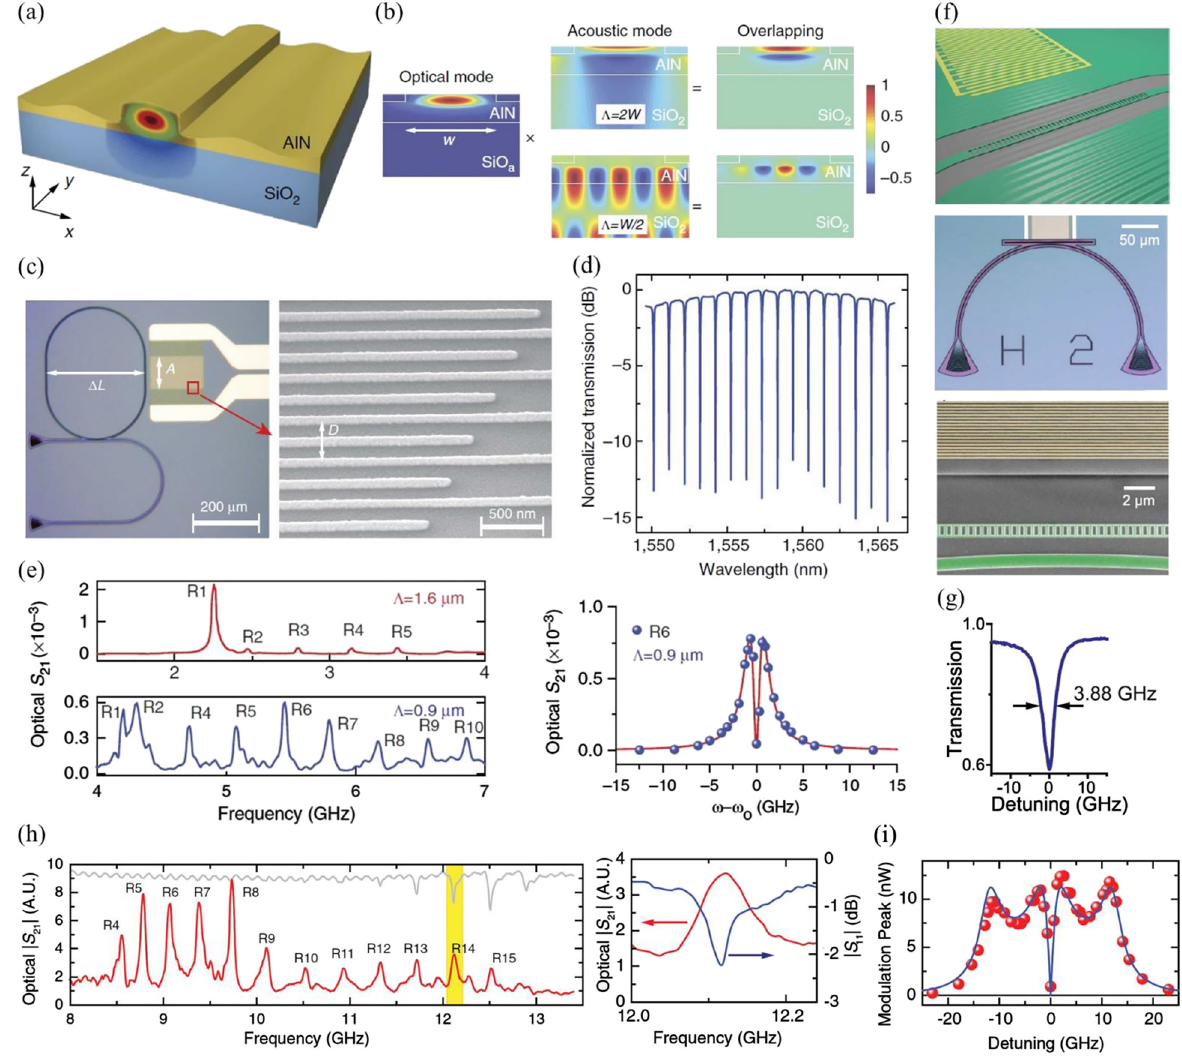
Figure 4: AlN-based integrated devices with SAW induced photon – phonon coupling. (a) Schematic of AlN waveguide illustrating the coupling between the SAW and optical mode. (b) Simulated optical mode, acoustic mode (under two acoustic wavelengths of 2W and W/2), and their intensity overlap within the AlN-based waveguide. (c) Left panel: optical microscopic image of fabricated system, showing IDT placed beside the racetrack ring resonator for SAW coupling. Two vertical couplers are used for optical mode coupling. Right panel: SEM image of IDT electrode fingers with a period D of 400 nm. (d) Optical transmission spectrum of the racetrack resonator, showing loaded Q of 4 × 10 4 , corresponding to an intrinsic Q of 8 × 10 4 . (e) Left panel: measured system spectra of S 21 transmission coef fi cient with peaks labeled with Rayleigh mode orders. Right panel: R6 mode modulation response with respect to the laser detuning relative to the optical resonance wavelength under acoustic wavelength of 0.9 μ m. (a) – (e) Adapted with permission from Springer Nature, Nature Communications [69]. Suboptical wavelength acoustic wave modulation of integrated photonic resonators at microwave frequencies, S. A. Tadesse, et al. Copyright 2014. (f) Top panel: schematic of SAW generated by IDT propagating towards the PhC nanocavity. Middle panel: microscopic image of the fabricated device, with two grating-based vertical couplers to couple light into and out of the waveguide, and metallic IDT for SAW coupling. Bottom panel: false-colored SEM image of PhC nanocavity side-coupled to a straight waveguide(markedingreen),andIDT(markedinyellow)forSAWgeneration.(g)Spectraoffundamentalmoderesonance(around1530nm)of the PhC nanocavity, showing a narrow linewidth of 3.88 GHz. (h) Left panel: spectra of system transmission coef fi cient S 21 and re fl ection coef fi cient S 11 . Right panel: zoom-in view of the transmission and re fl ection spectra for R14 mode. (i) Peak value of S 21 under various laser detuning relative to the cavity resonance for R14 mode. Measured data (red dots) are fi tted with theoretical model (blue line). (f) – (i) Adapted with permission from [107] © The Optical